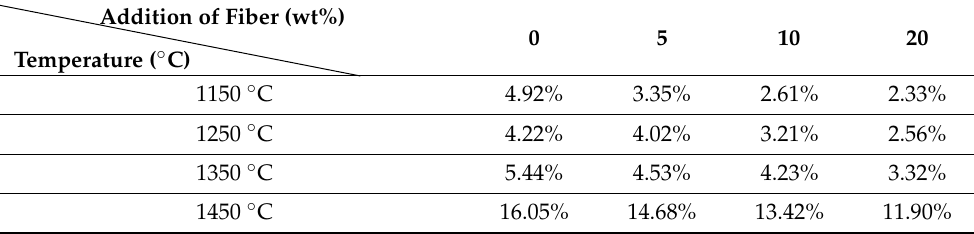
Table A2. Linear shrinkage of geopolymer